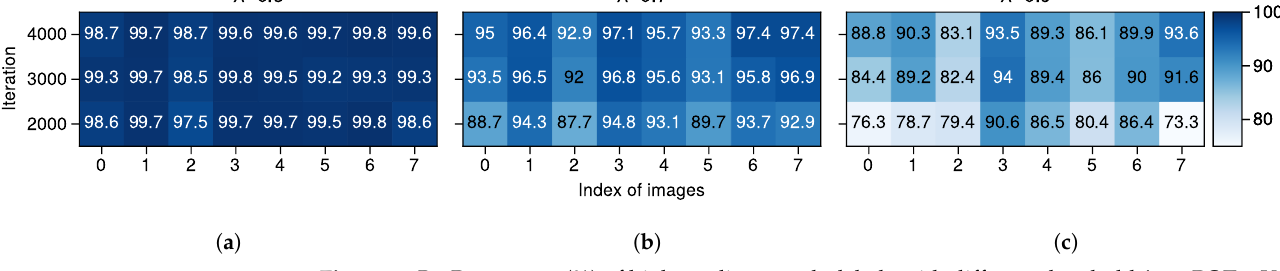
Figure 8. P h : Percentage (%) of high-quality pseudo-labels with different threshold λ on POT → VAI, calculated from eight randomly selected images. ( a ) λ = 0.5. ( b ) λ = 0.7. ( c ) λ =